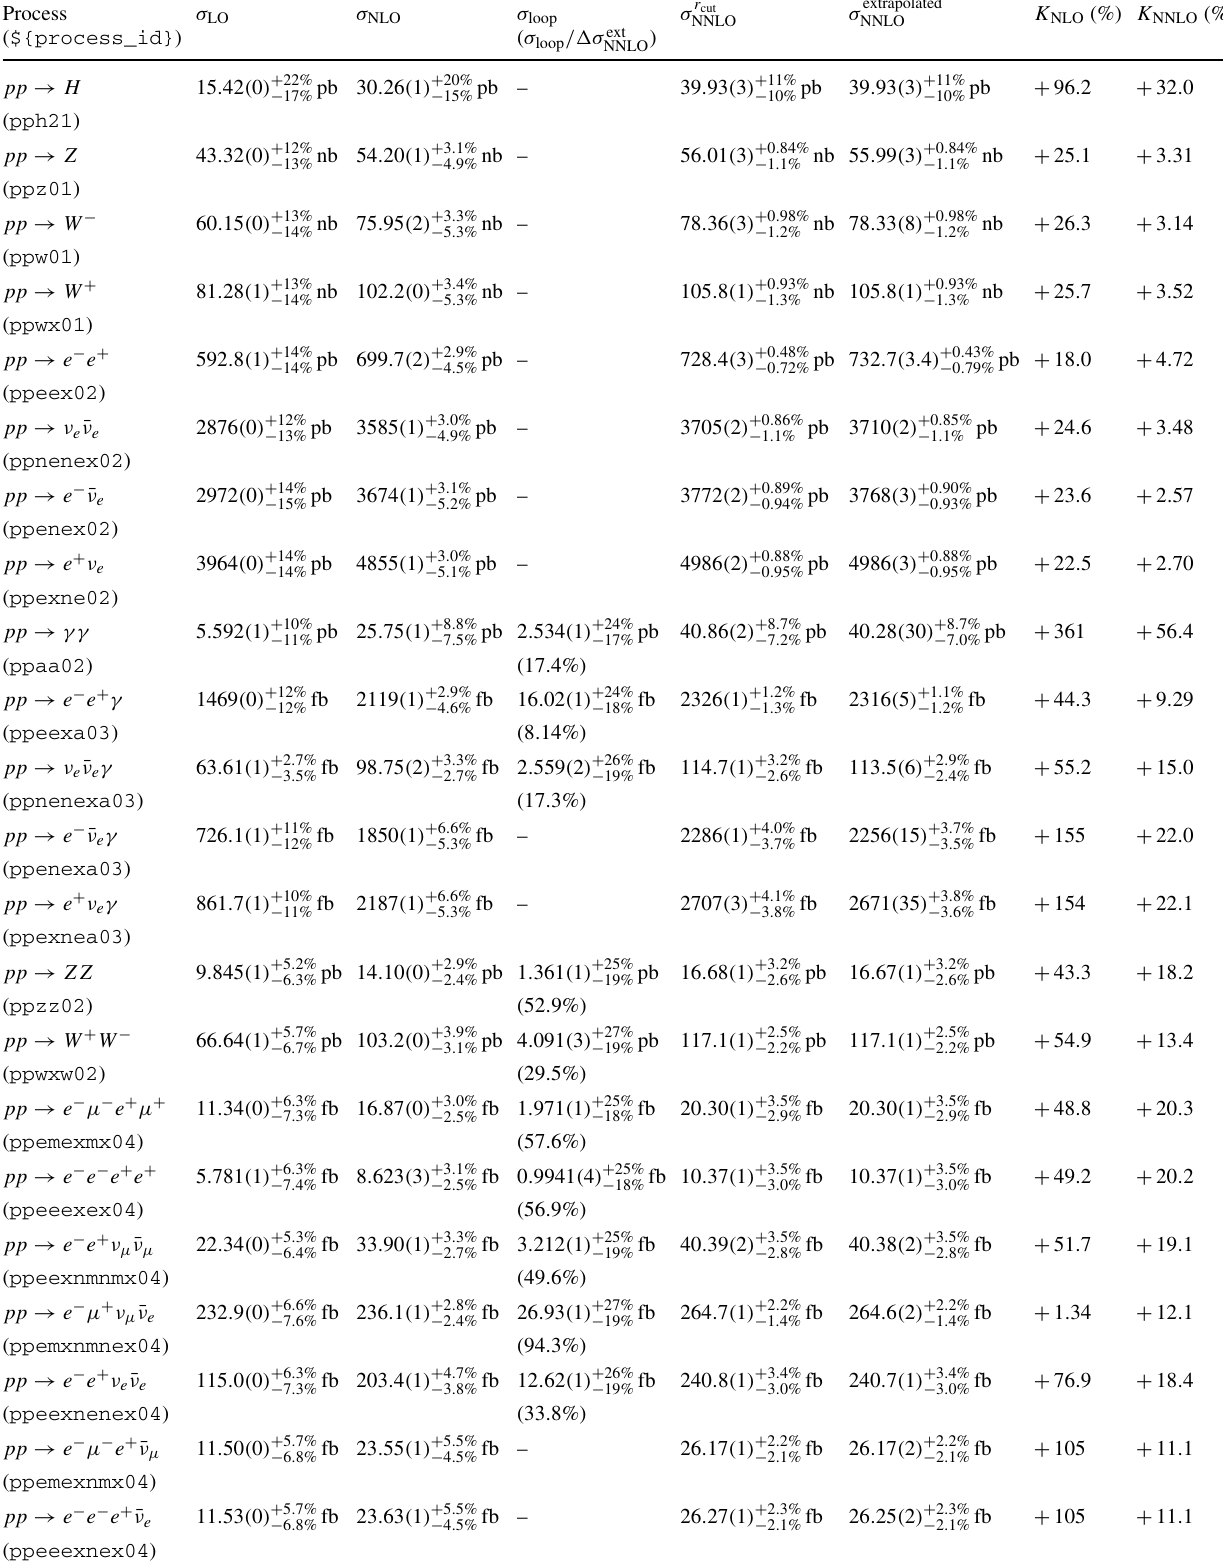
Table 6 Integrated cross sections for all available processes in Matrix using the default setups